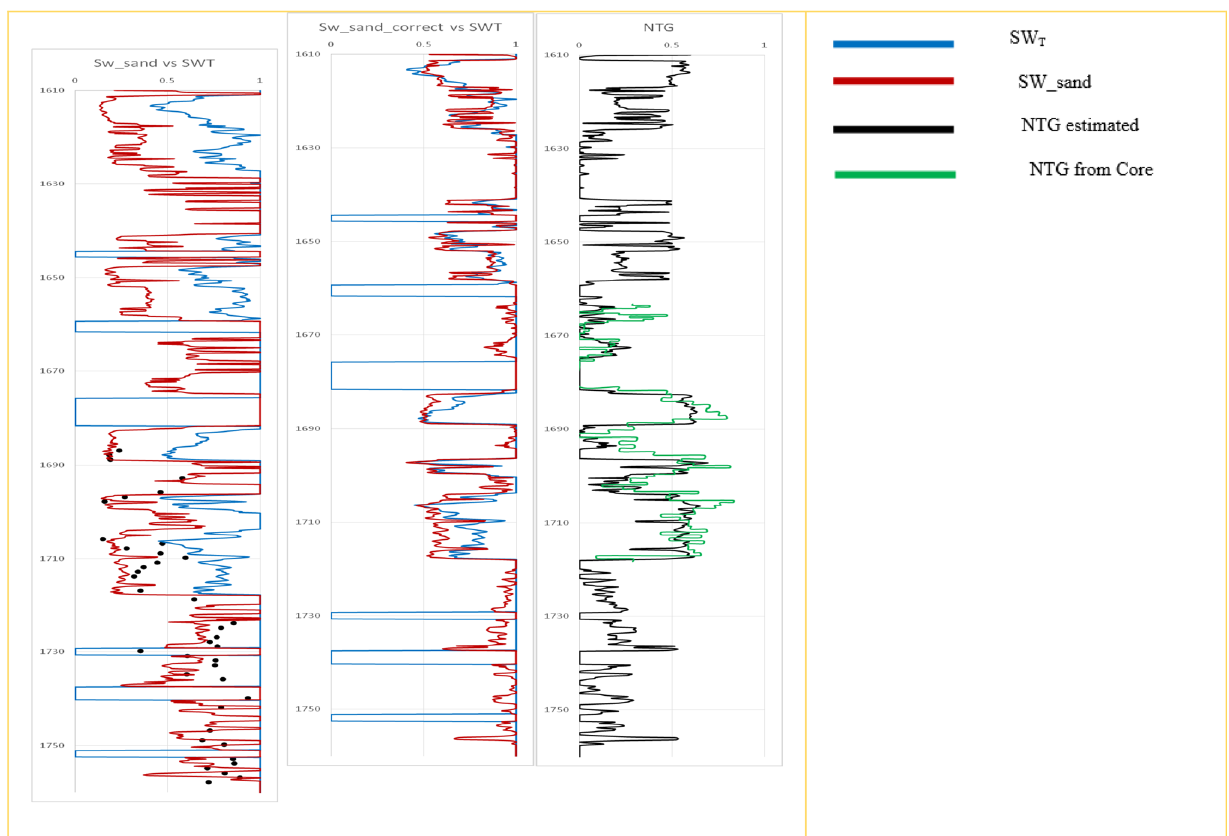
Fig. 11 Comparison of SW e for sand versus log SW T (left), calculated SW T using NTG approach versus log SW T (middle) and the core derived NTG versus estimated NTG log